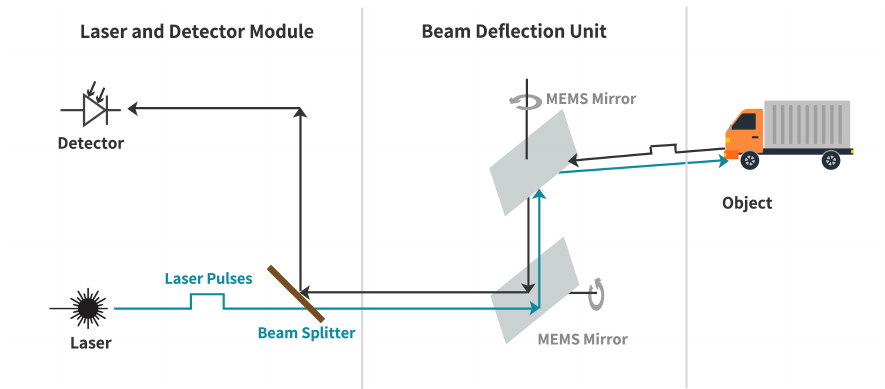
Figure 2. Block diagram of MEMS LiDAR sensor, source: adapted with permission from [31].